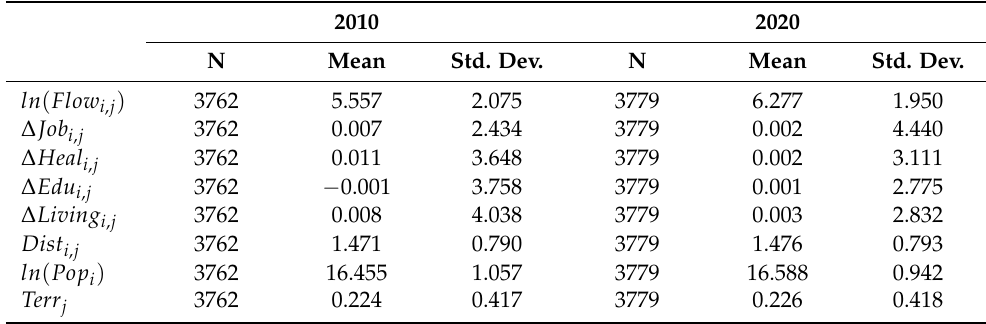
Table 1. Descriptive statistics for migration flows and related